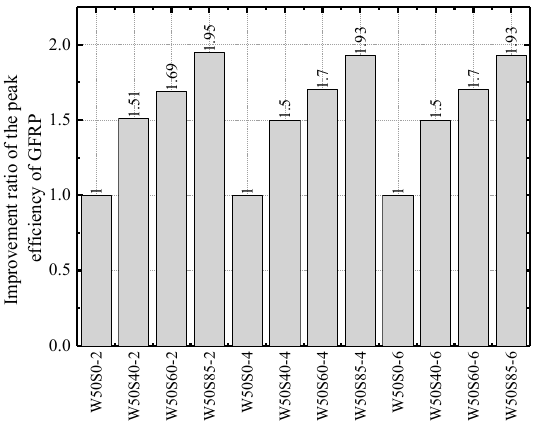
Figure 14. Peak efficiency of GFRP.